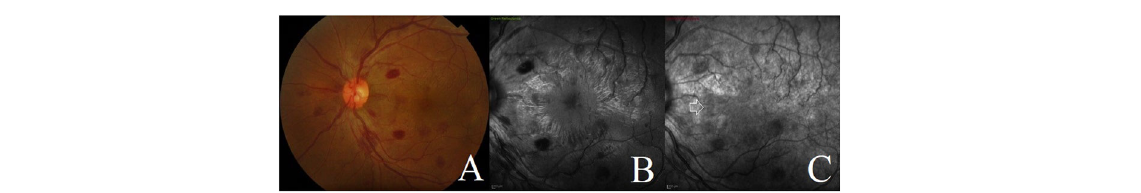
Fig. 1 Conventional colour fundus photograph and multicolour imaging of the left eye at presentation. a Conventional colour fundus photograph of the left eye showing the multiple flame-shaped and deep retinal haemorrhages spread across the retina along with dilated and tortuous retinal veins suggestive of central retinal vein occlusion. b Thirty degrees of green reflectance image showing the dark hyporeflectance patches corresponding to the retinal haemorrhages. c Thirty degrees of infrared reflectance image showing a diffuse patch of hyporeflectance involving the nasal, superior and inferior macular quadrants corresponding to the AMN lesion (white arrow). The retinal haemorrhages appear less dark on infrared reflectance compared to the green reflectance